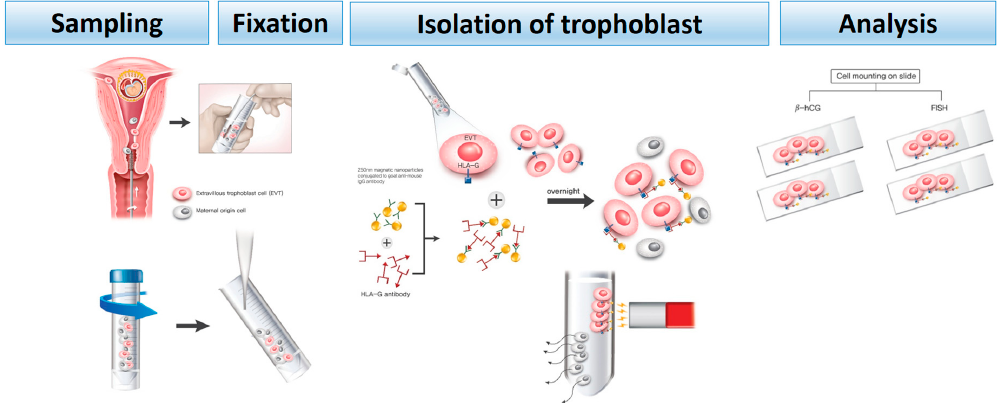
Figure 1. Four-step methodology for post-fixation trophoblast retrieval and isolation from the cervix (TRIC). Sampling: A cytobrush was used as it is used in a Pap test. Fixation: The collected sample was